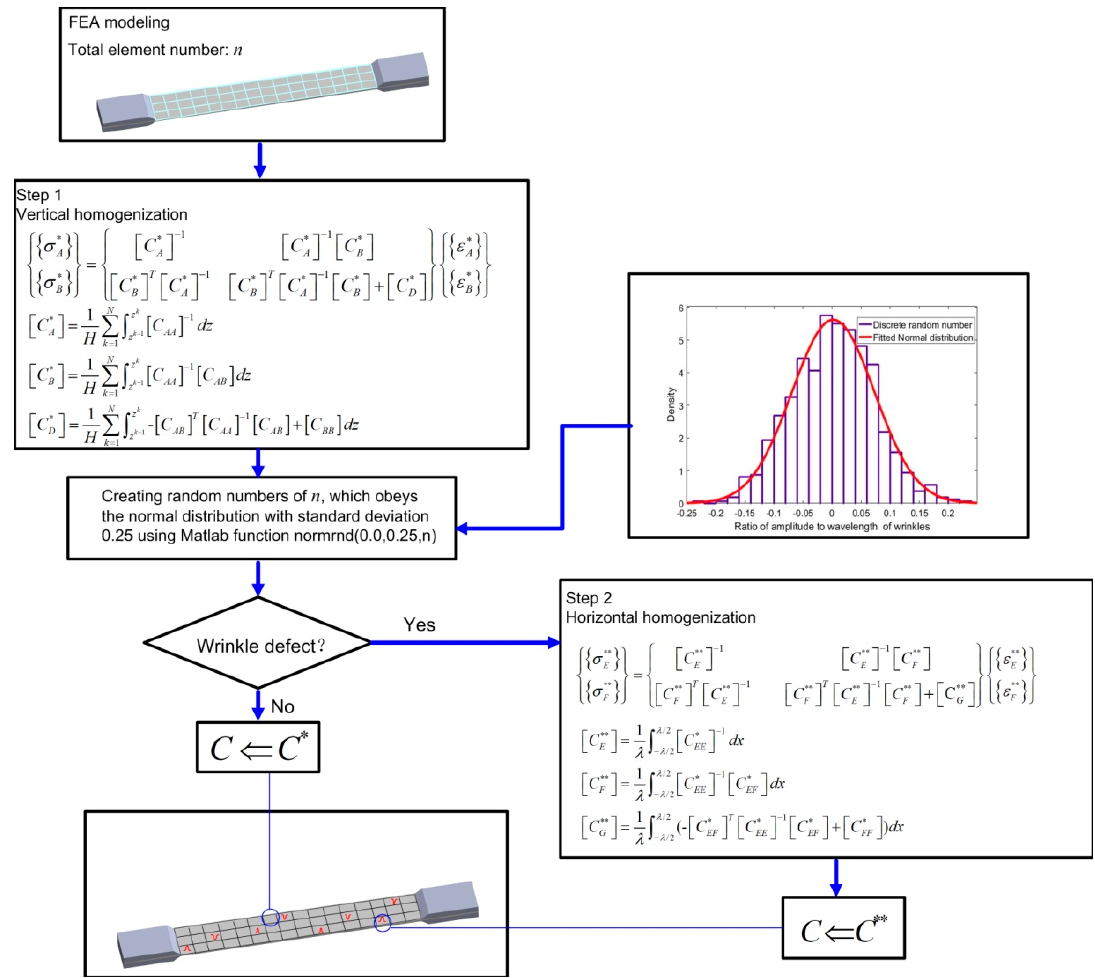
Figure 4. Wrinkle defects implanted in structure *: the equations can be referenced in Appendix A. A normal distribution function is designed to obtain a wrinkle ratio between 0 and 0.25. In the finite element (FE) model, the wrinkle defect is regarded as a disturbance to the stiffness matrix of each element. The degree of this disturbance depends on the value of the wrinkle ratio. If the ratio is zero, the stiffness of the element reflects that of idealized laminate. In this way, the heterogeneity model was implanted in finite element analysis (FEA), and the behavior of a structure with randomly distributed wrinkles can be